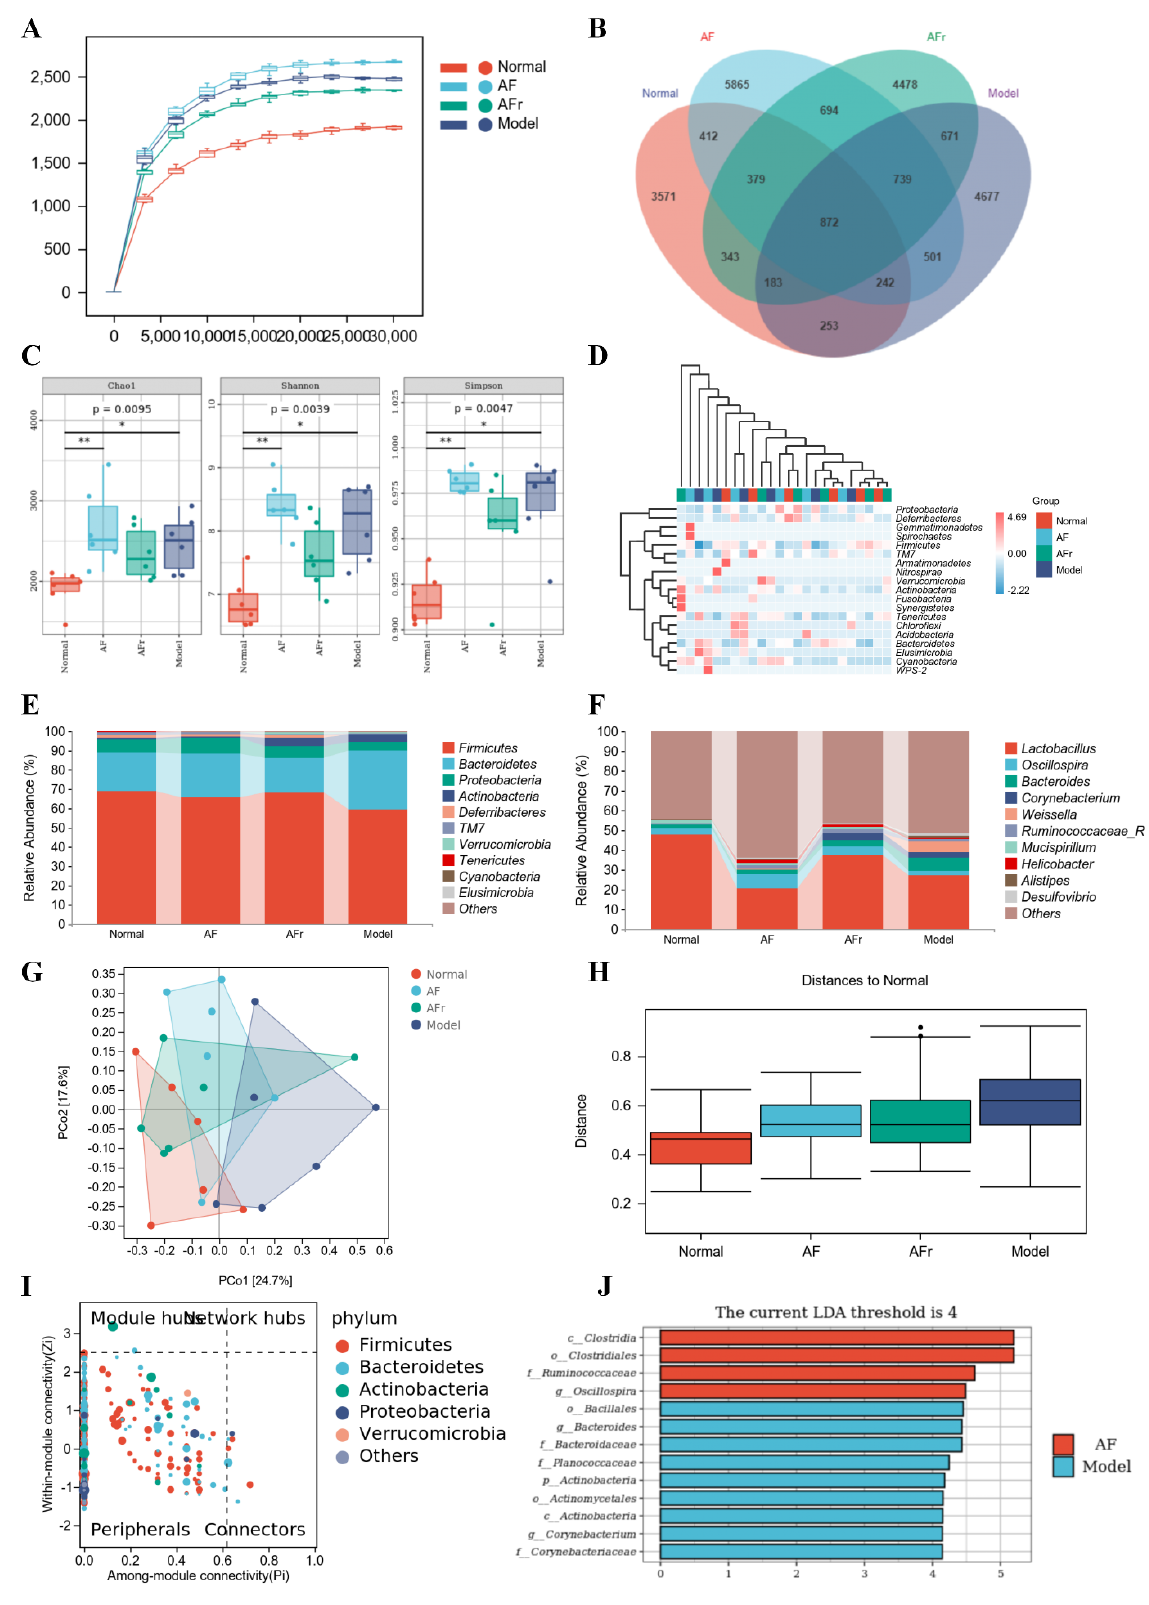
Figure 7. Effect of A. tenuissimum flower on gut microbiota consumption. Rarefaction curve ( A ), ASV/OTU Venn diagram ( B ), alpha diversity analysis ( C , * p < 0.05, ** p < 0.01), the heat map of species composition at the phylum level ( D ), the gut microbiota abundance at the phylum level ( E ), and the gut microbiota abundance at the genus level ( F ), PCoA analysis ( G ), permutational multivariate analysis of variance ( H ), ZIPI − score diagram ( I ), and LEfSe analysis ( J ).